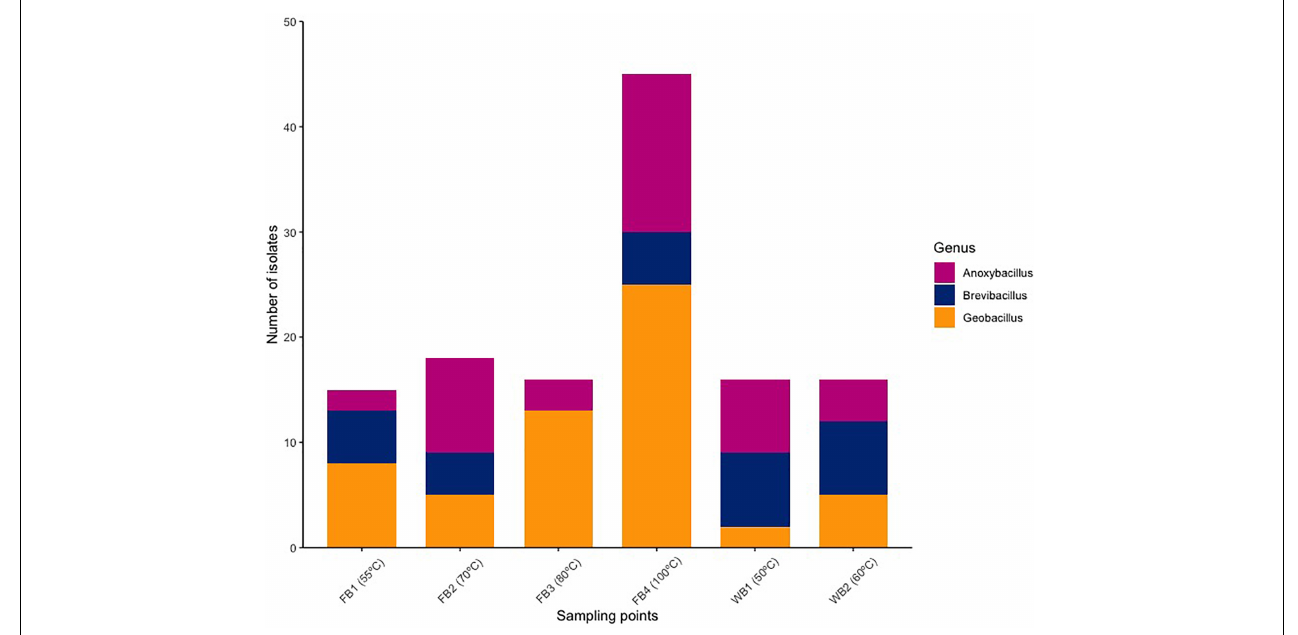
FIGURE 1 | Relative abundances of the taxonomic groups assigned to the isolates grown at 55 ◦ C, at the maximum classification level. Environmental temperatures of each sample are shown. Sequences were assigned with 97% similarity against the SILVA database v. 132.